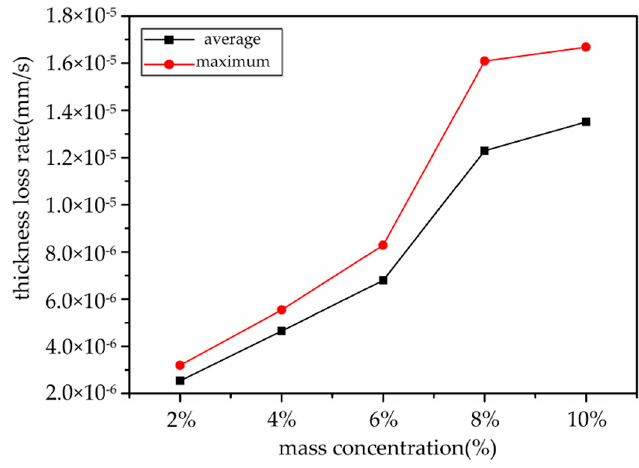
Figure 15. Thickness loss rate at the outlet area A of the blade working surface at 600 rpm.